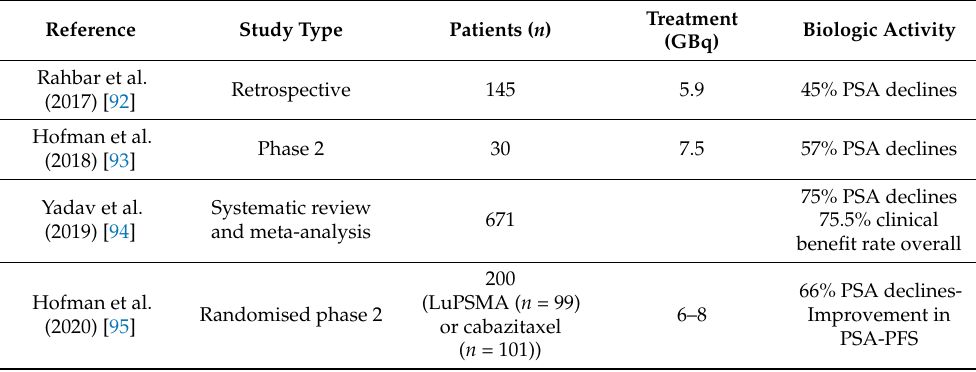
Table 4. Summary of 177Lu PSMA-617